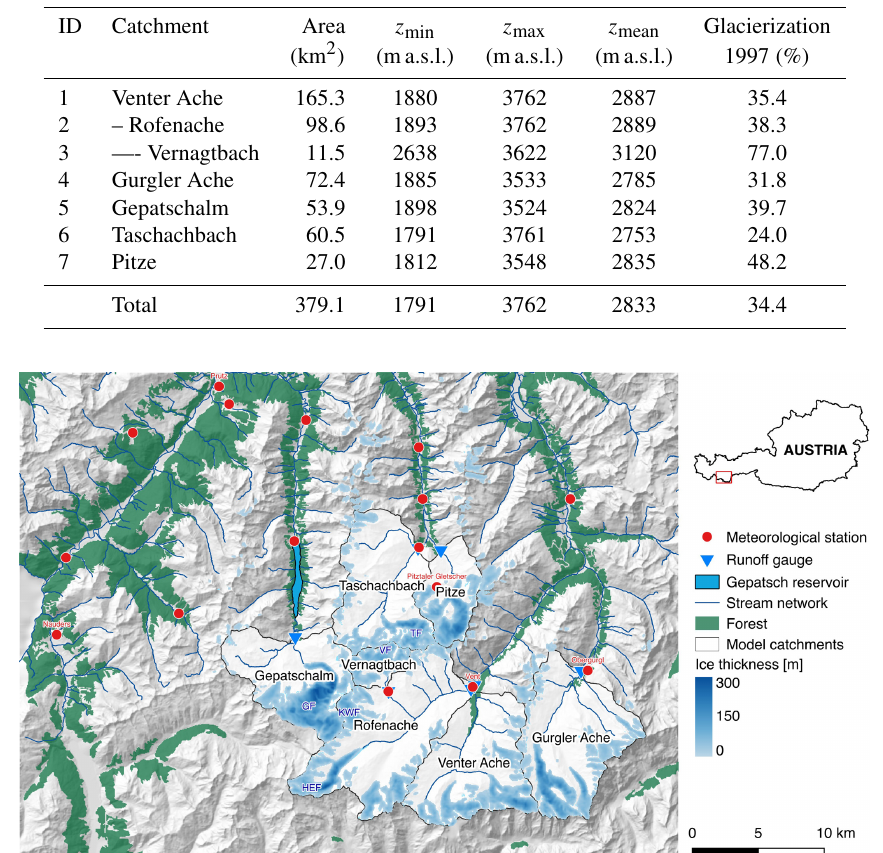
Table 1. Area, elevation, and glacierization (as of 1997) of the investigated catchments. The catchment IDs correspond to the labels in Fig. 1. Indentations indicate subcatchments.